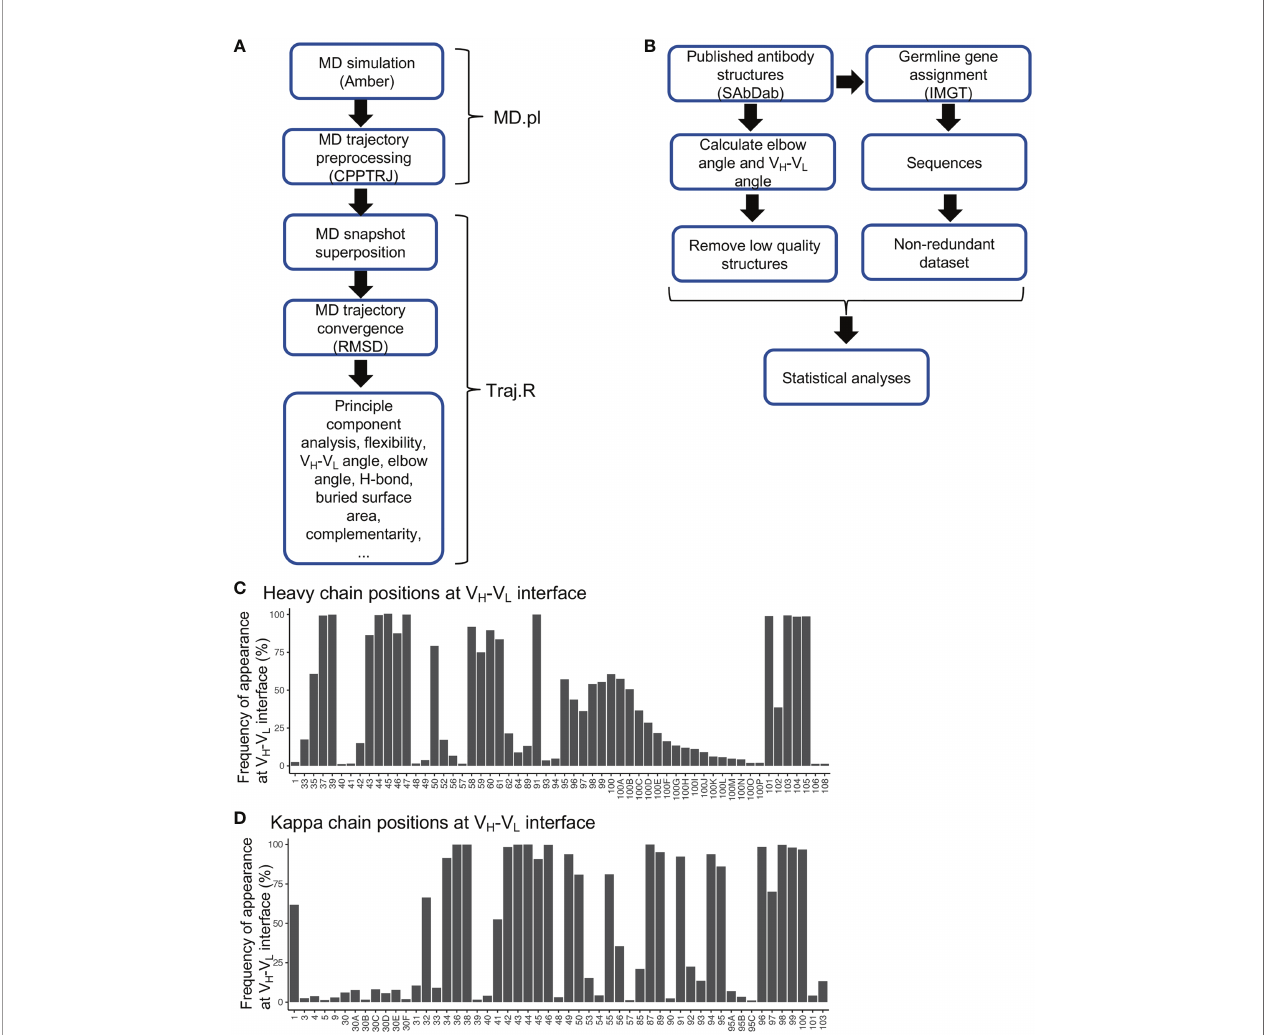
FIGURE 1 | Diagrams for MD simulation and PDB structural analyses and frequencies of residues at V H -V L interface. (A) Diagram of MD simulation and analyses performed. (B) Diagram for analyzing antibody structures from the PDB database. (C) Frequencies of heavy chain variable domain residue positions at V H -V L interface. Residues with frequency less than 1% were omitted. (D) Frequencies of kappa chain variable domain residues at V H -V L interface. Residues with frequency less than 1% were